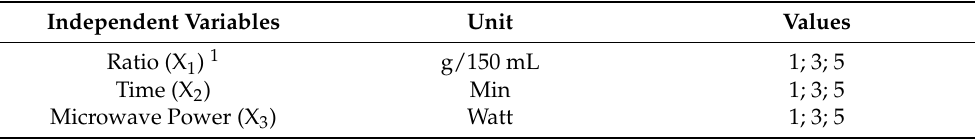
Table 1. Independent variables, unit and values of experimental